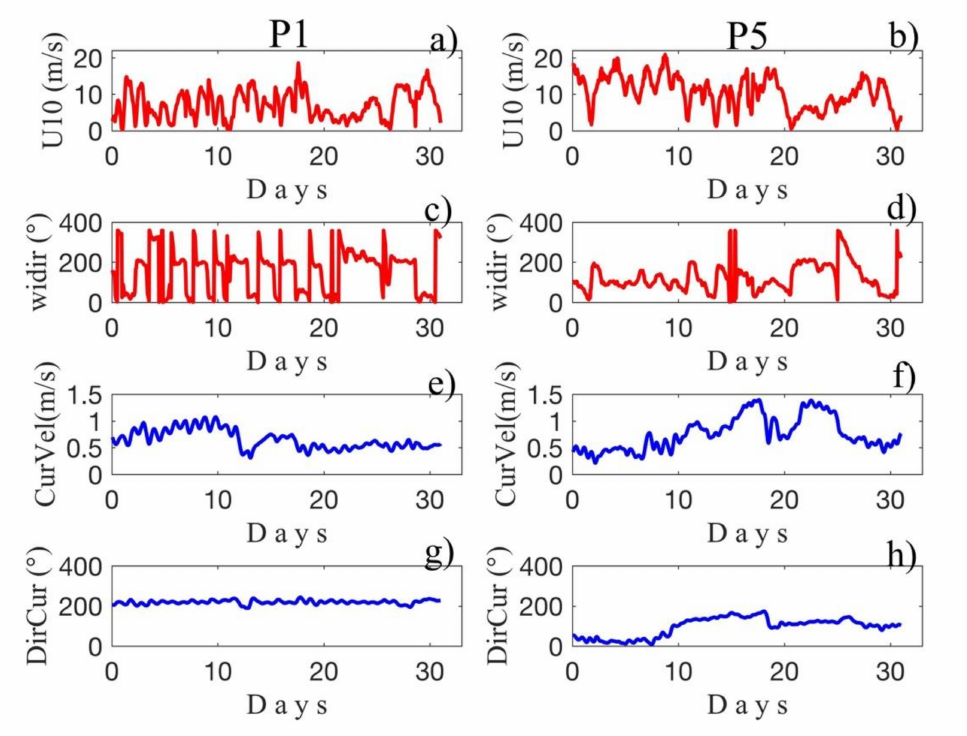
Figure 5. Time series for the Wind speed ( a , b ), Wind Direction ( c , d ), Current speed ( e , f ), Current direction ( g , h ) at P1 ( left ) and at P5 ( right ). Simulation period: 15 June 2018–15 July